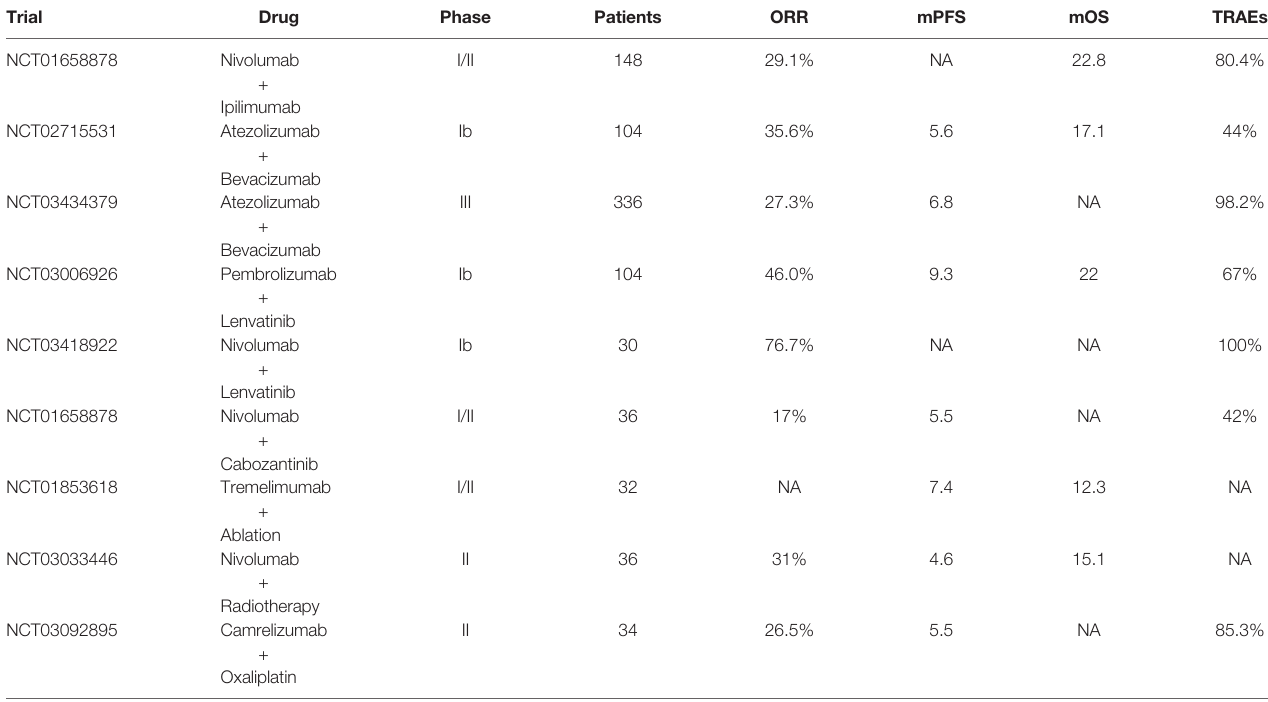
TABLE 2 | Clinical trials of combined therapies based on immune checkpoint inhibitors for advanced HCC. Trial